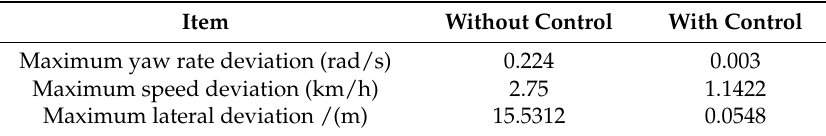
Figure 7. Experimental comparison with/without control under E1 condition. Table 10. Statistical control effect under E1 condition.